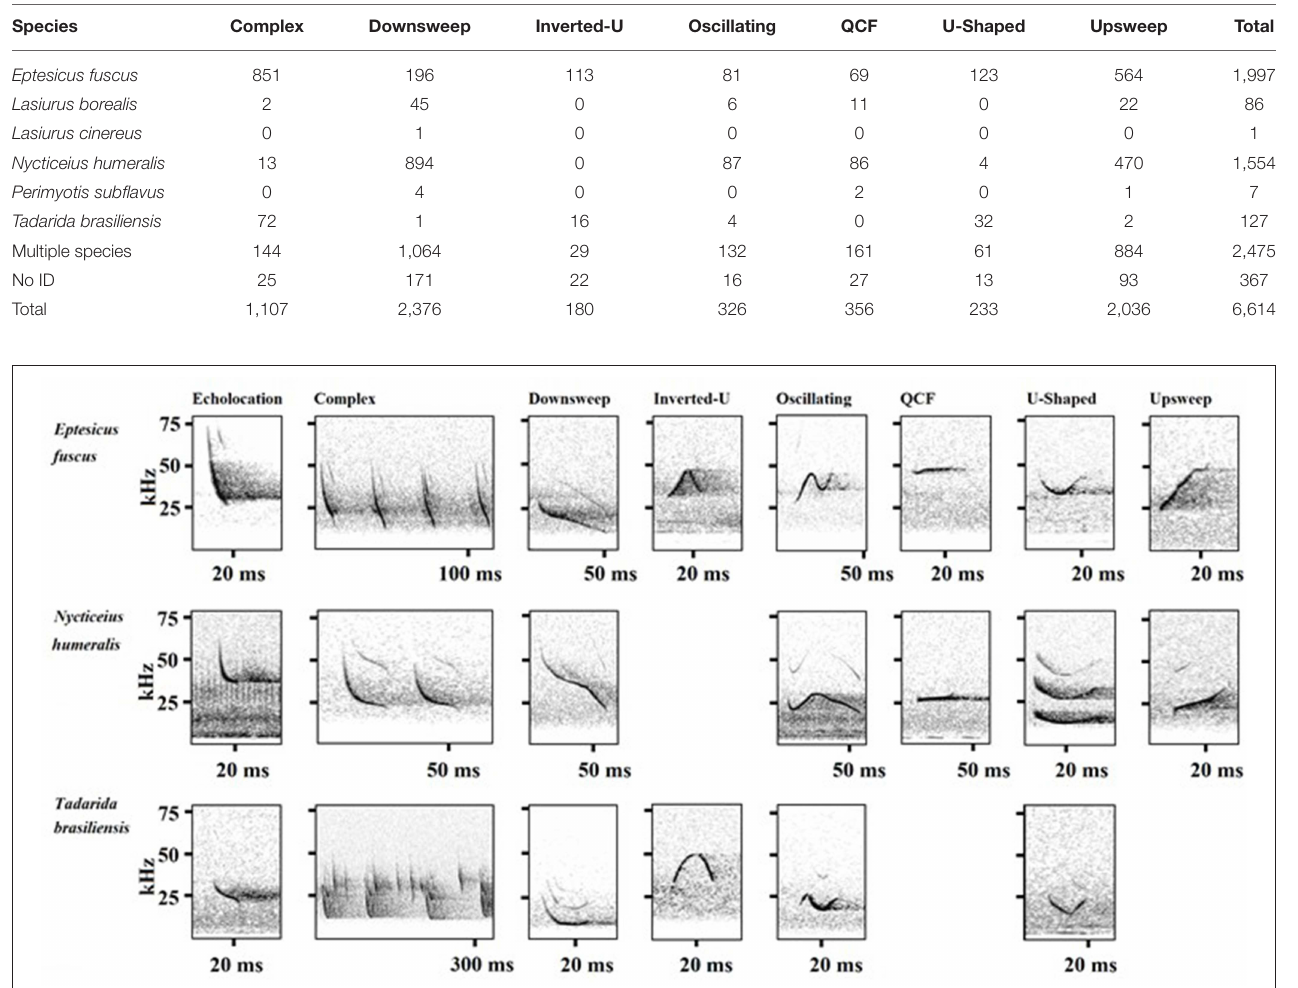
FIGURE 1 | Representative spectrograms of echolocation and in-flight social calls of Eptesicus fuscus , Nycticeius humeralis , and Tadarida brasiliensis collected at the UNCG Wetlands, Greensboro, NC, from March 15th, 2017 to June 30th, 2018. Species-specific differences in spectral and temporal characteristics were tested for and detected in the complex calls of E. fuscus and T. brasiliensis [Wilks’ λ : 0.290; c. F (6,216) = 88.0; p < 0.0001], the downsweep calls of E. fuscus and N. humeralis [Wilks’ λ : 0.592; c. F (5,370) = 51.0; p < 0.0001], the oscillating calls of E. fuscus and N. humeralis [Wilks’ λ : 0.317; c. F (5,42) = 18.1; p < 0.0001], and the upsweep